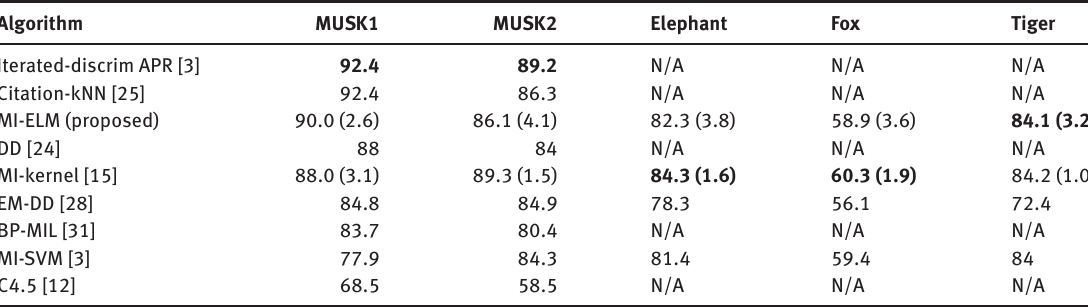
Table 2: MI-ELM Performance on Benchmark Data Sets.